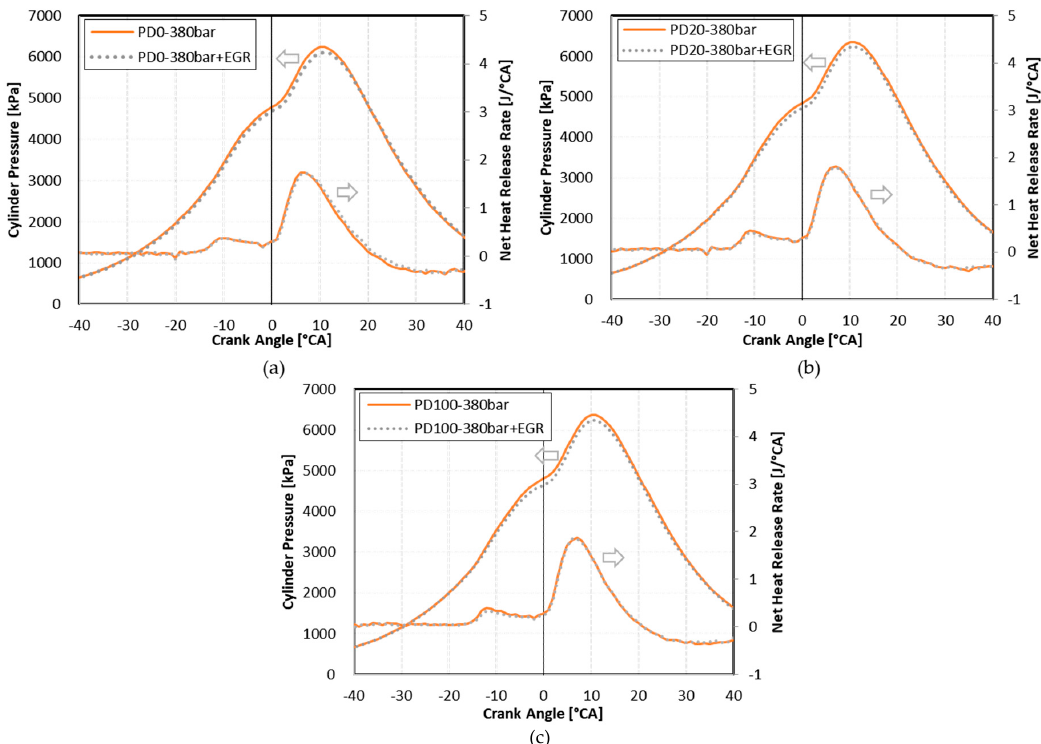
Figure 4. Combustion pressure and heat release rate with exhaust gas recirculation (EGR) rate 10% under 380 bar. ( a ) PD0, ( b ) PD20, and ( c ) PD100.